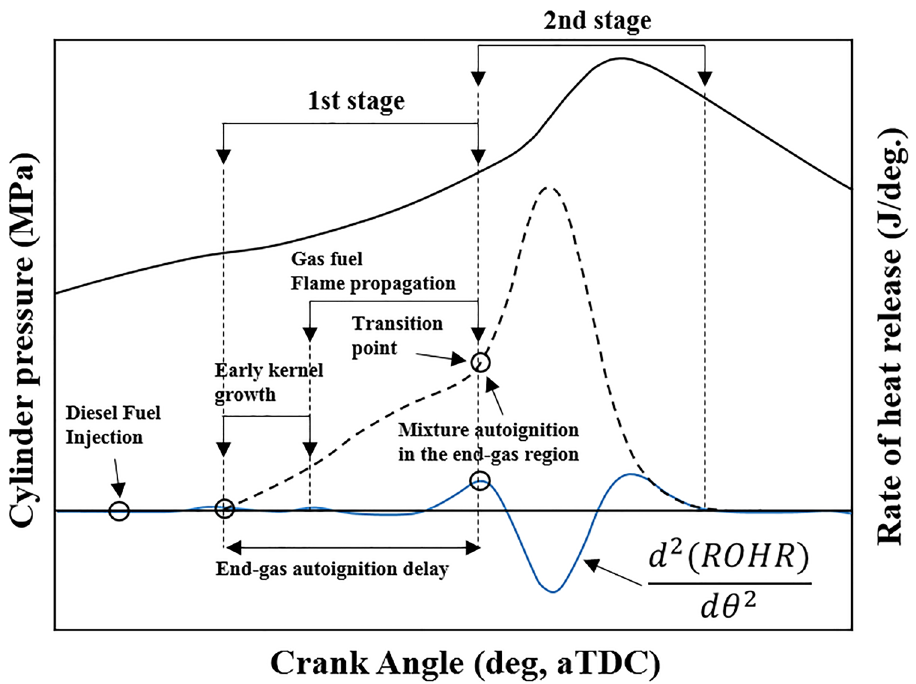
Figure 5. Concept of PREMIER combustion 43